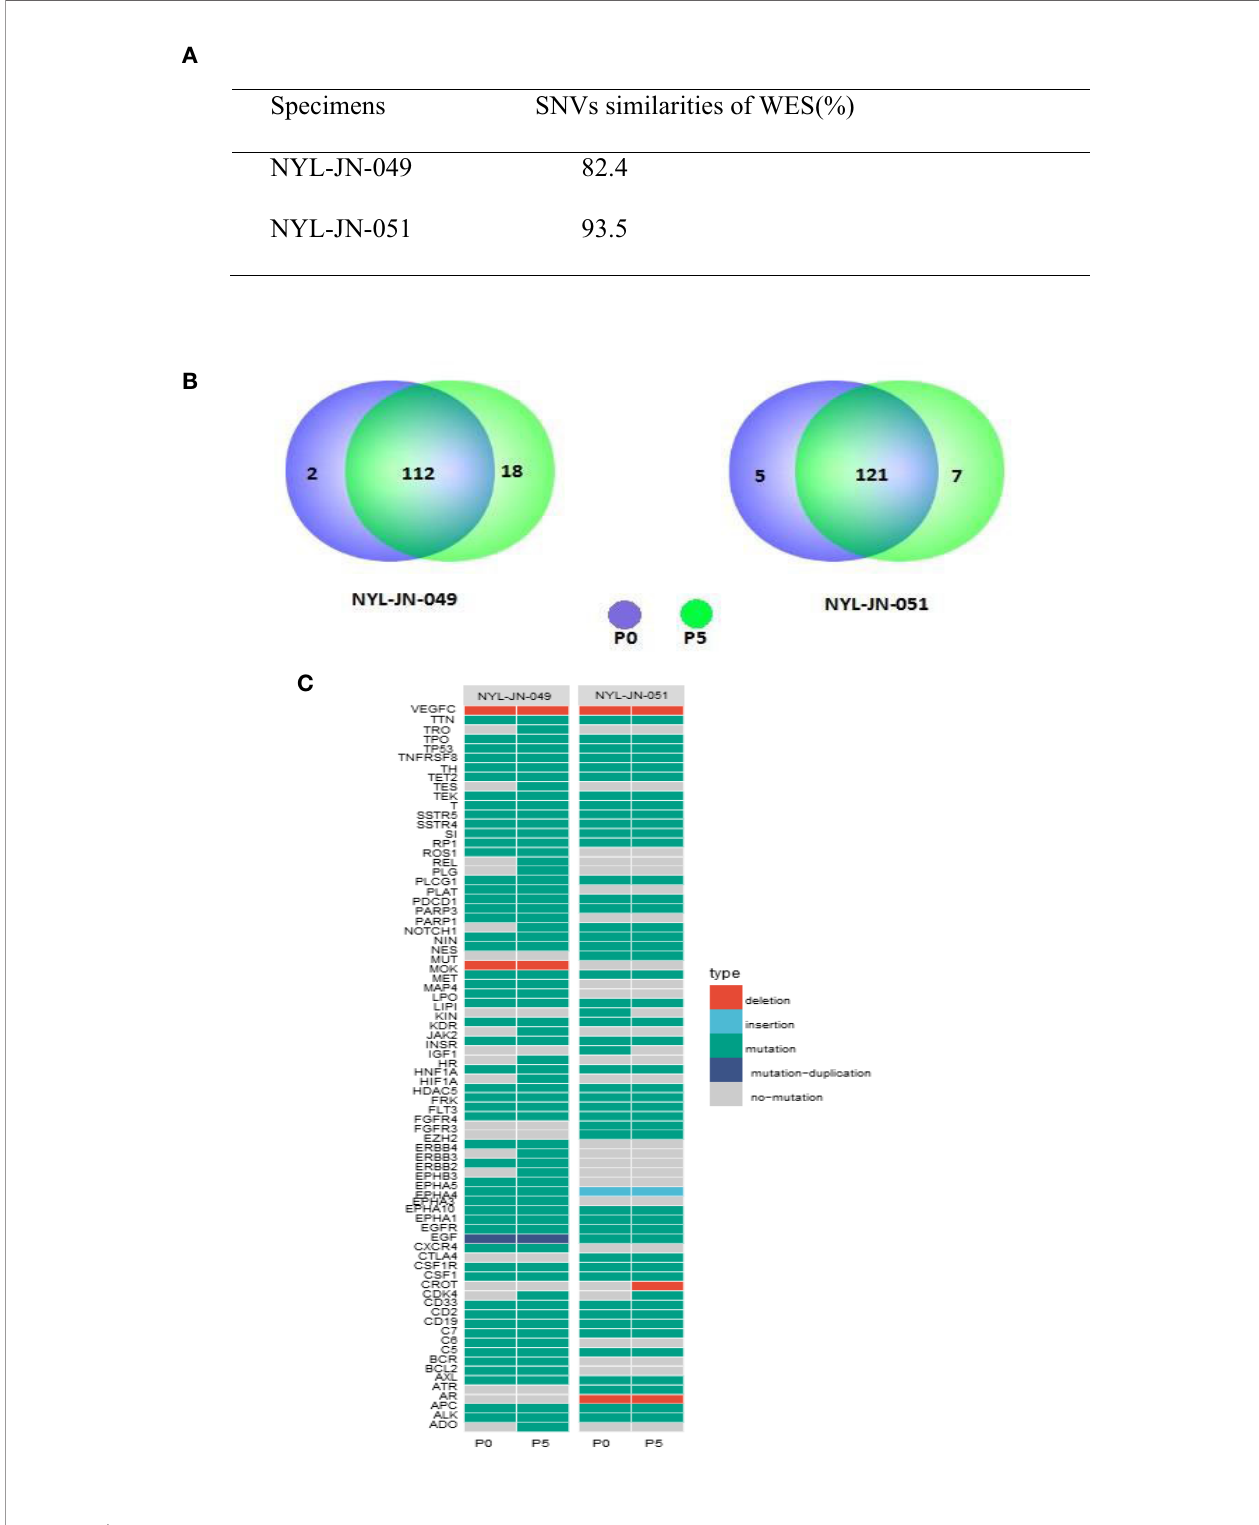
FIGURE 5 | Genetic analysis of the i-CR cells. (A) SNV similarities between P0 and P5 i-CR cells. (B) Venn diagrams of SNVs in cancer-related genes for P0 and P5 i-CR cells. (C) Heatmap of genetic pro fi les of cancer-related GC genes between P0 and P5 i-CR